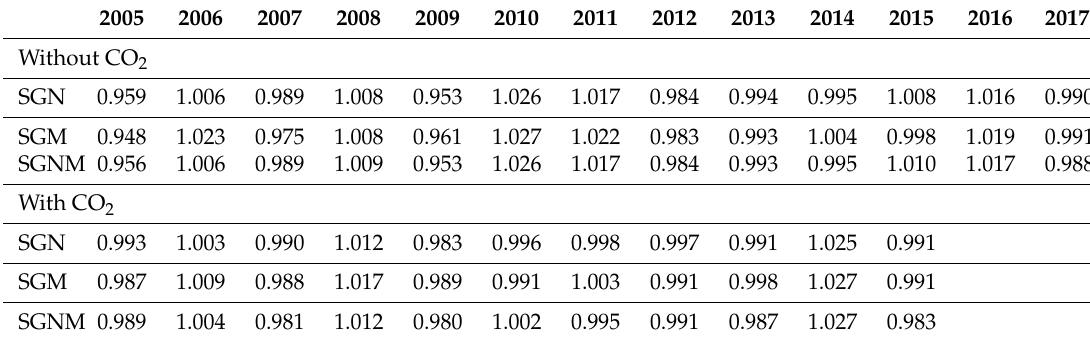
Table 4. Annual means of SGN, SGM and